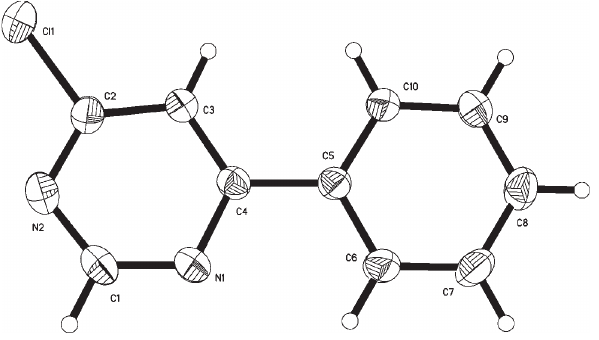
Table 1: Data collection and handling.